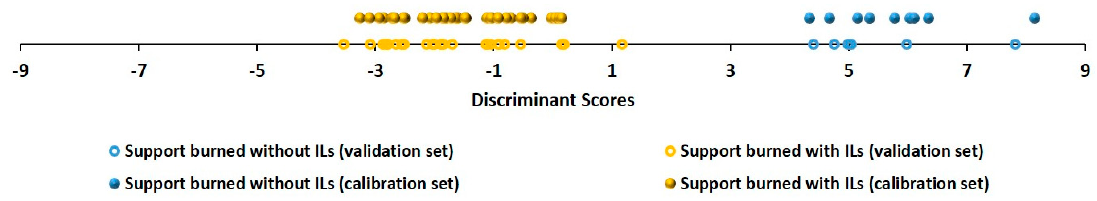
Figure 2. Discriminant scores obtained from linear discriminant analysis (LDA) for all of the fire debris samples (D 80 × 428 ).